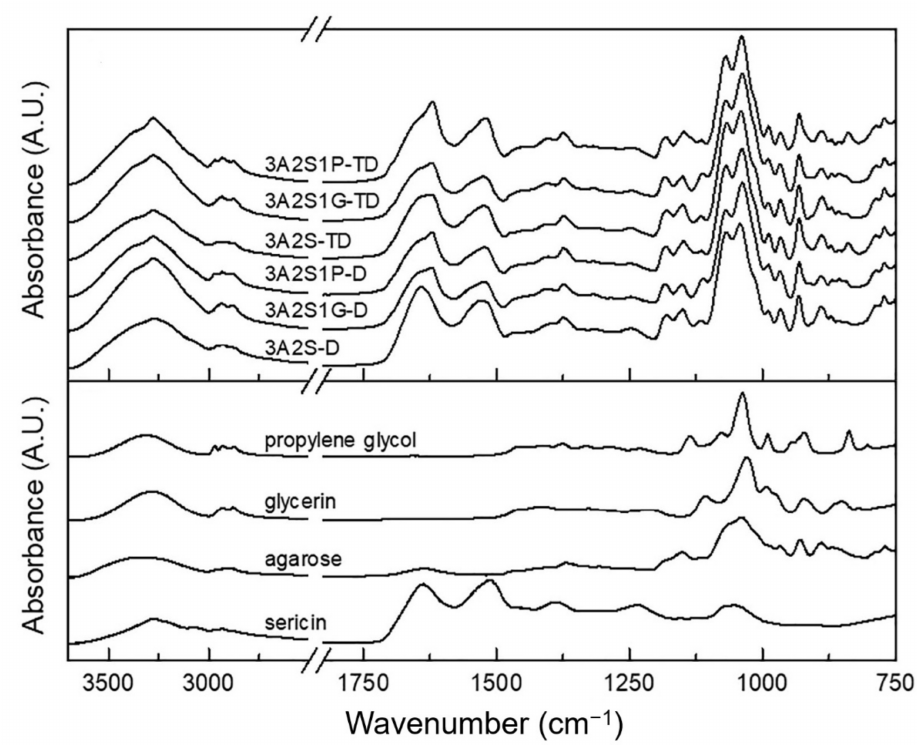
Figure 5. IR spectra of scaffolds (3A2S, 3A2S1G, 3A2S1P) that were prepared by the freeze-drying method (D) and by freeze-thawing together with the freeze-drying method (TD), and the raw materials used to prepare the scaffolds.